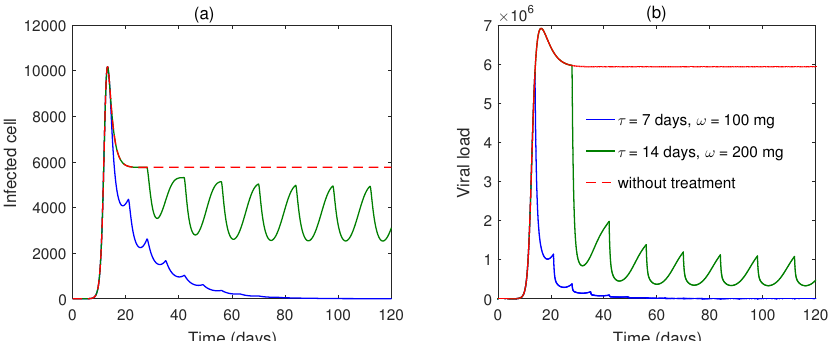
Figure 8. ( a , b ) Solutions of impulsive Model (4) shown for impulse interval τ = 7 days with dosing rate ω = 100 mg (blue line), and impulse interval of τ = 14 days with dosing rate ω = 200 mg (green